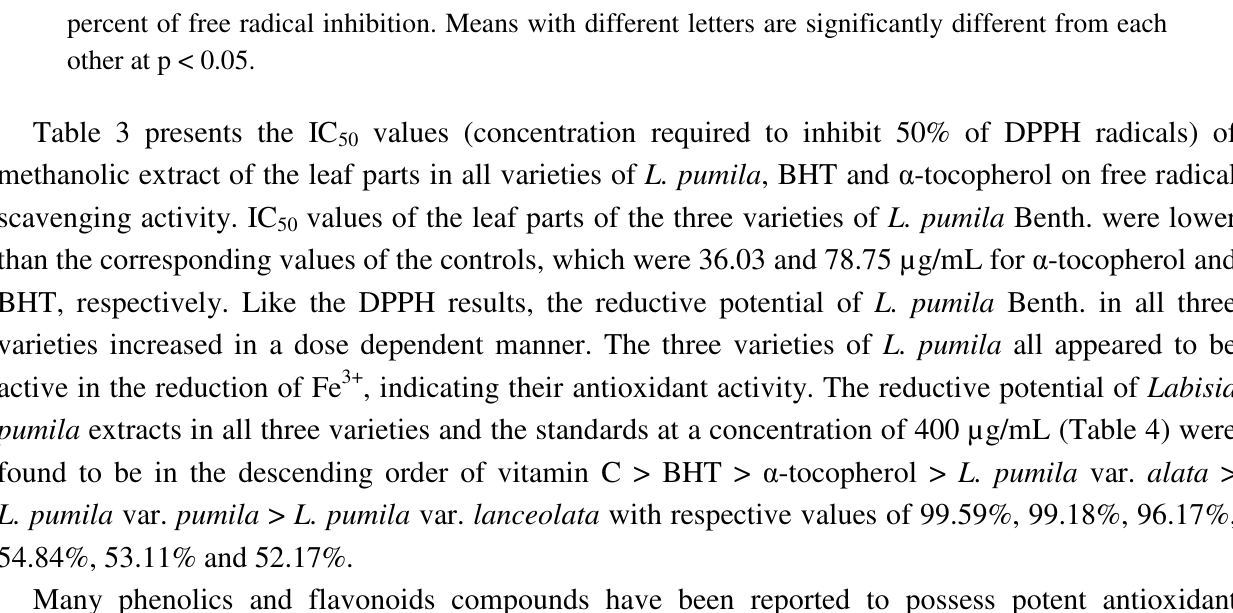
Table 2. DPPH scavenging activities of the leaf part in all varieties of L. pumila at concentration of 400 µ g/mL. BHT and α -tocopherol were used as positive controls. Inhibition (%) Variety